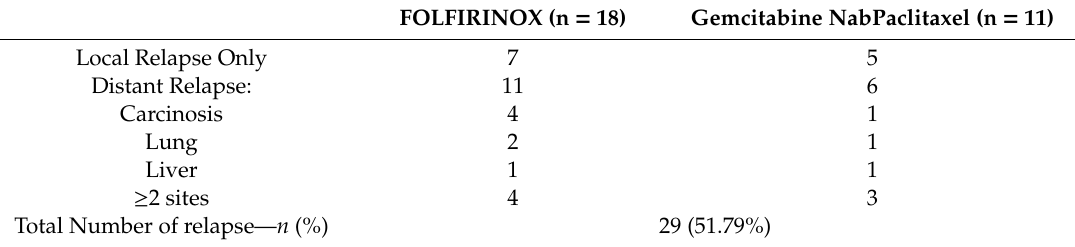
Table 2. Recurrence pattern following resection in 29 LAPC patients.